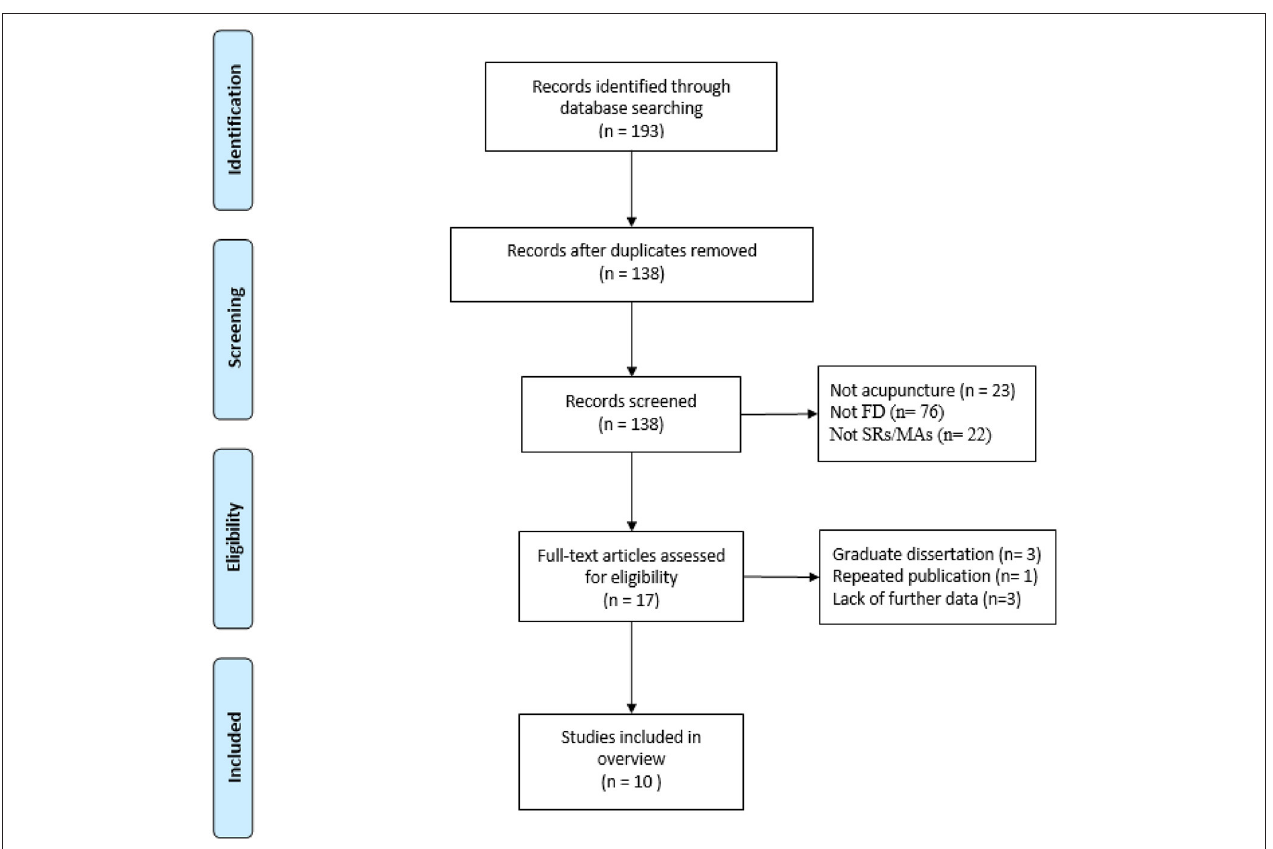
FIGURE 1 | Literature screening